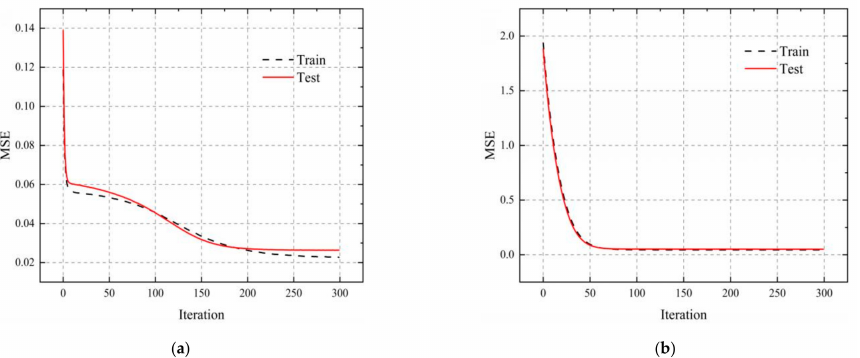
Figure 15. ( a ) Mean square error iterative curve of motion parameter and average thrust coefficient fit- ting function ( b ) Mean square error iterative curve of the fitting function between motion parameters and average propulsion